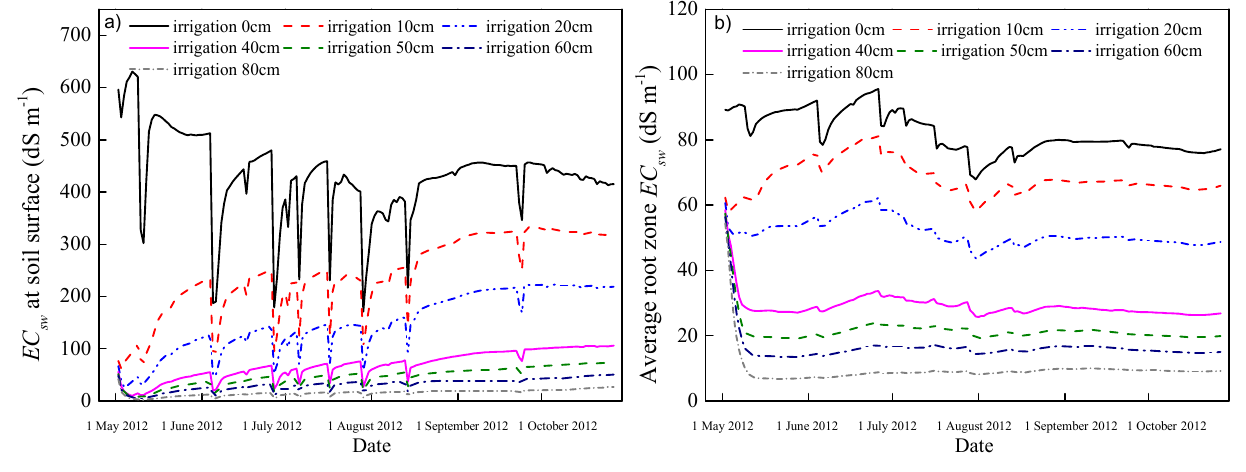
Figure 8. Cumulative root water uptake of Chinese tamarisk with different irrigation amounts.